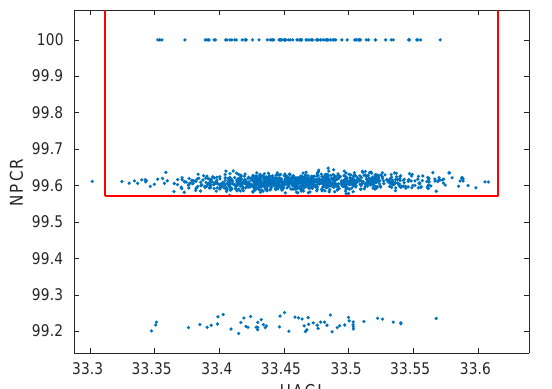
Figure 12. The NPCR and UACI measures of pairs of cipher images corresponding to the Lena image generated by the proposed scheme using the same secret